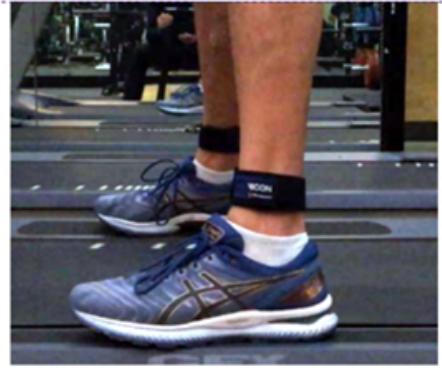
Figure 1. Example placement of the IMU device on the